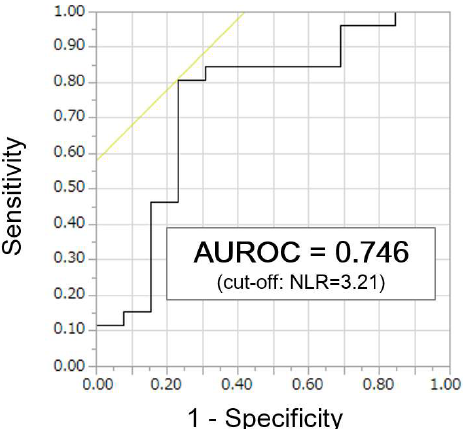
Figure 4. Receiver operating characteristic curve analysis to identify optimal cut-off value of neutrophil-to-lymphocyte ratio (NLR) to predict response to atezolizumab + bevacizumab combination therapy (AUROC, area under the receiver operating characteristic).